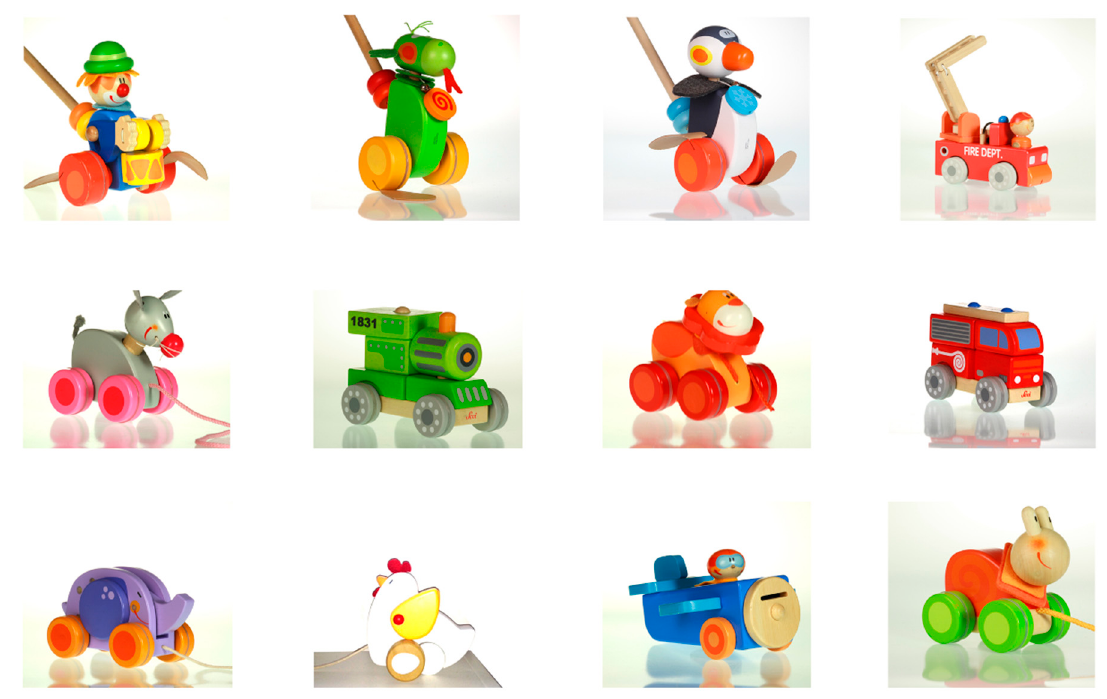
Figure 3. Copies of original Sevi’s toys rebuilt by the